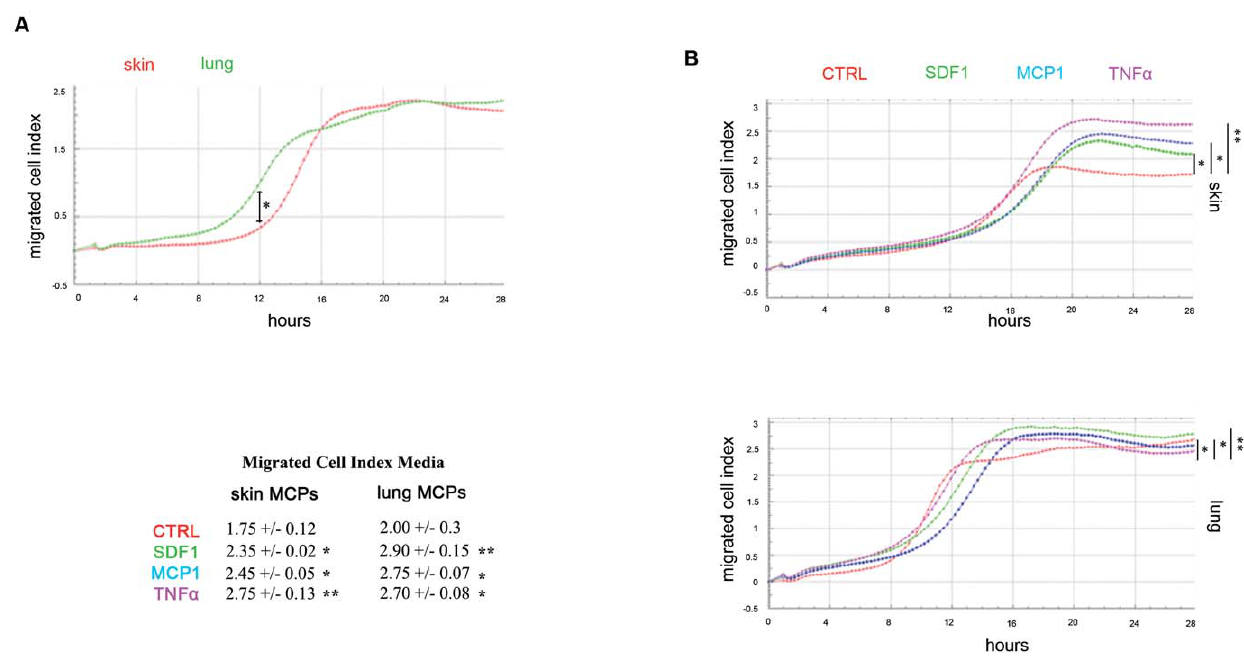
Figure 5. Mesenchymal precursor migration. A. Migration of undifferentiated skin (red) and lung (green) MPCs analyzed by a well insert assay in the Real Time Cell Analyzer. One representative experiment out of 9 independent wells of MPCs cultures is shown. Migrated Cell index is the relative number of migrated cells. Differences between skin and lung at 12 h were statistically significant by ANOVA (*p , 0.04). B. Migration of skin and lung MPCs in response to cytokines. The indicated stimuli were placed in the lower chambers in the migration assay. One representative experiment out of 9 independent wells of lung and skin MPCs cultures in presence of cytokines is shown. Data were analyzed as in A. Differences between control and stimulated cells were statistically significant by ANOVA (*p , 0.05; **p , 0.04). Table with the mean of migrated cell index for the nine control or stimulated MPCs clones is shown. CTRL, un-stimulated control cultures.